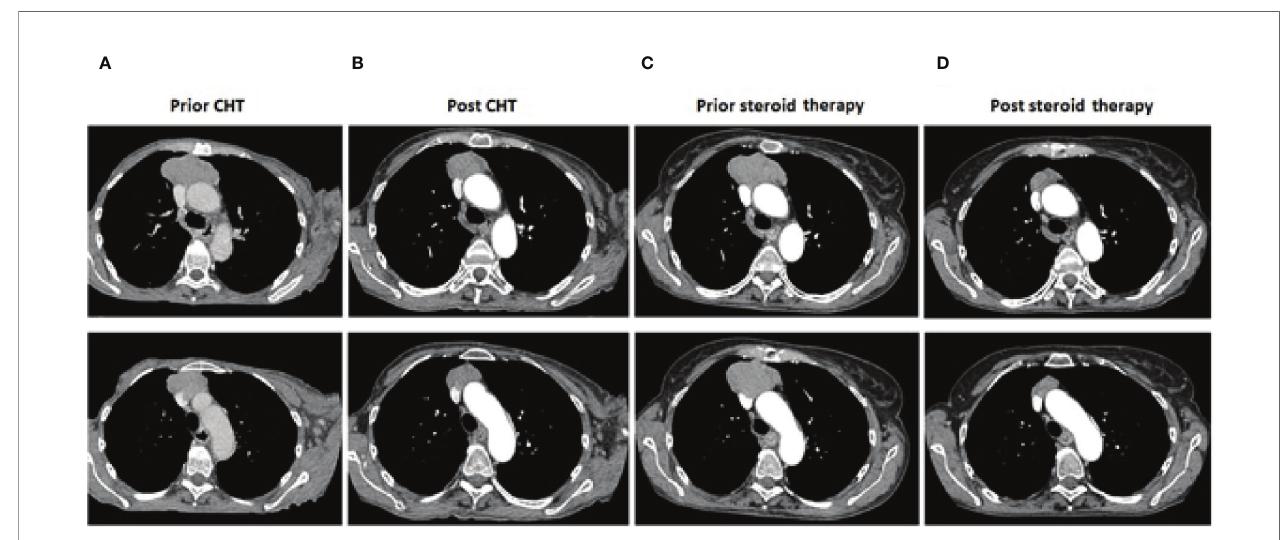
FIGURE 2 | Thymoma. Computer tomography imaging showing maximal tumor dimensions (upper row) and in fi ltration on VCS (bottom row): (A) prior systemic treatment (64 x 30 x 76 mm); (B) after completion of chemotherapy (51 x 26 x 70 mm); (C) prior corticosteroids implementation (65x63x75mm); (D) after three months of corticosteroid therapy (30x17mm).